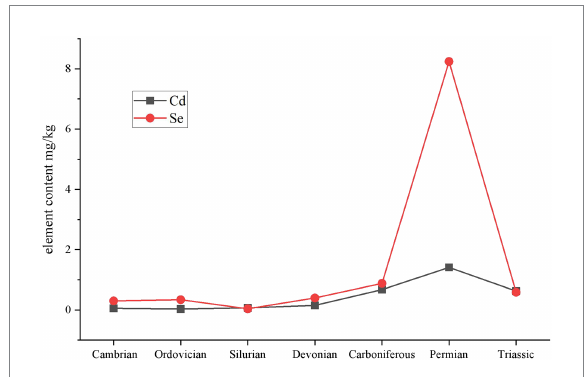
FIGURE 1 Comparison of Cd and Se contents in different stratigraphic units.